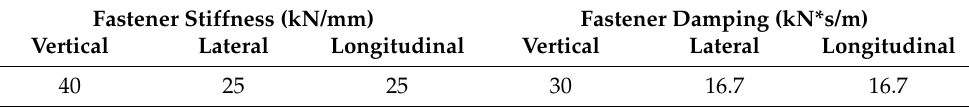
Figure 2. Part of the profiles of the rail with a variable cross-section. Table 1. The stiffness and damping parameters of the track. Fastener Stiffness (kN/mm)